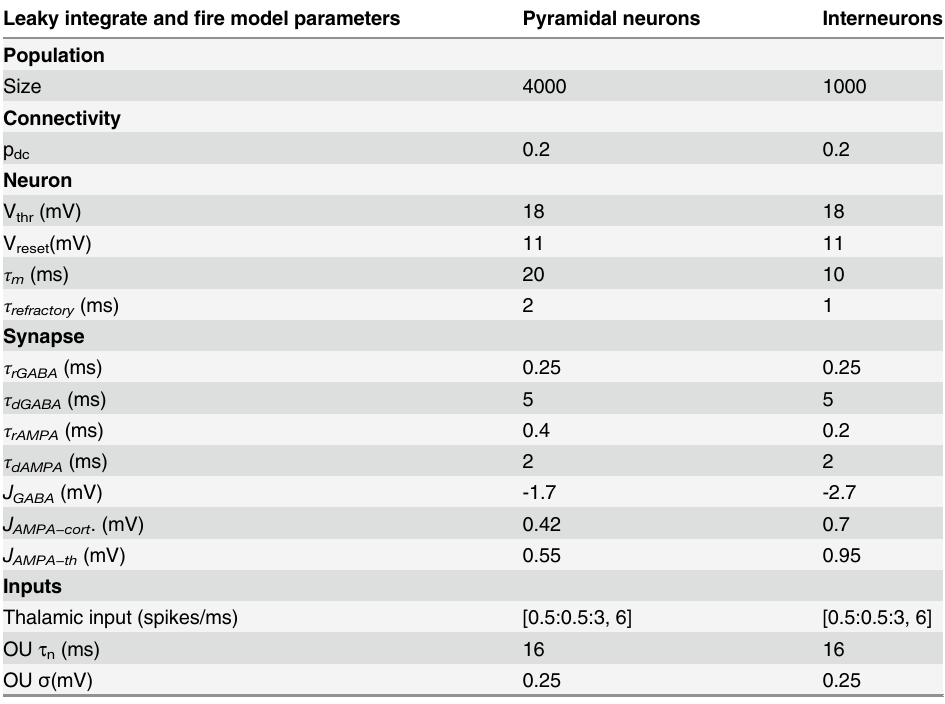
Table 2. Parameters for the two cell types used in the LIF network